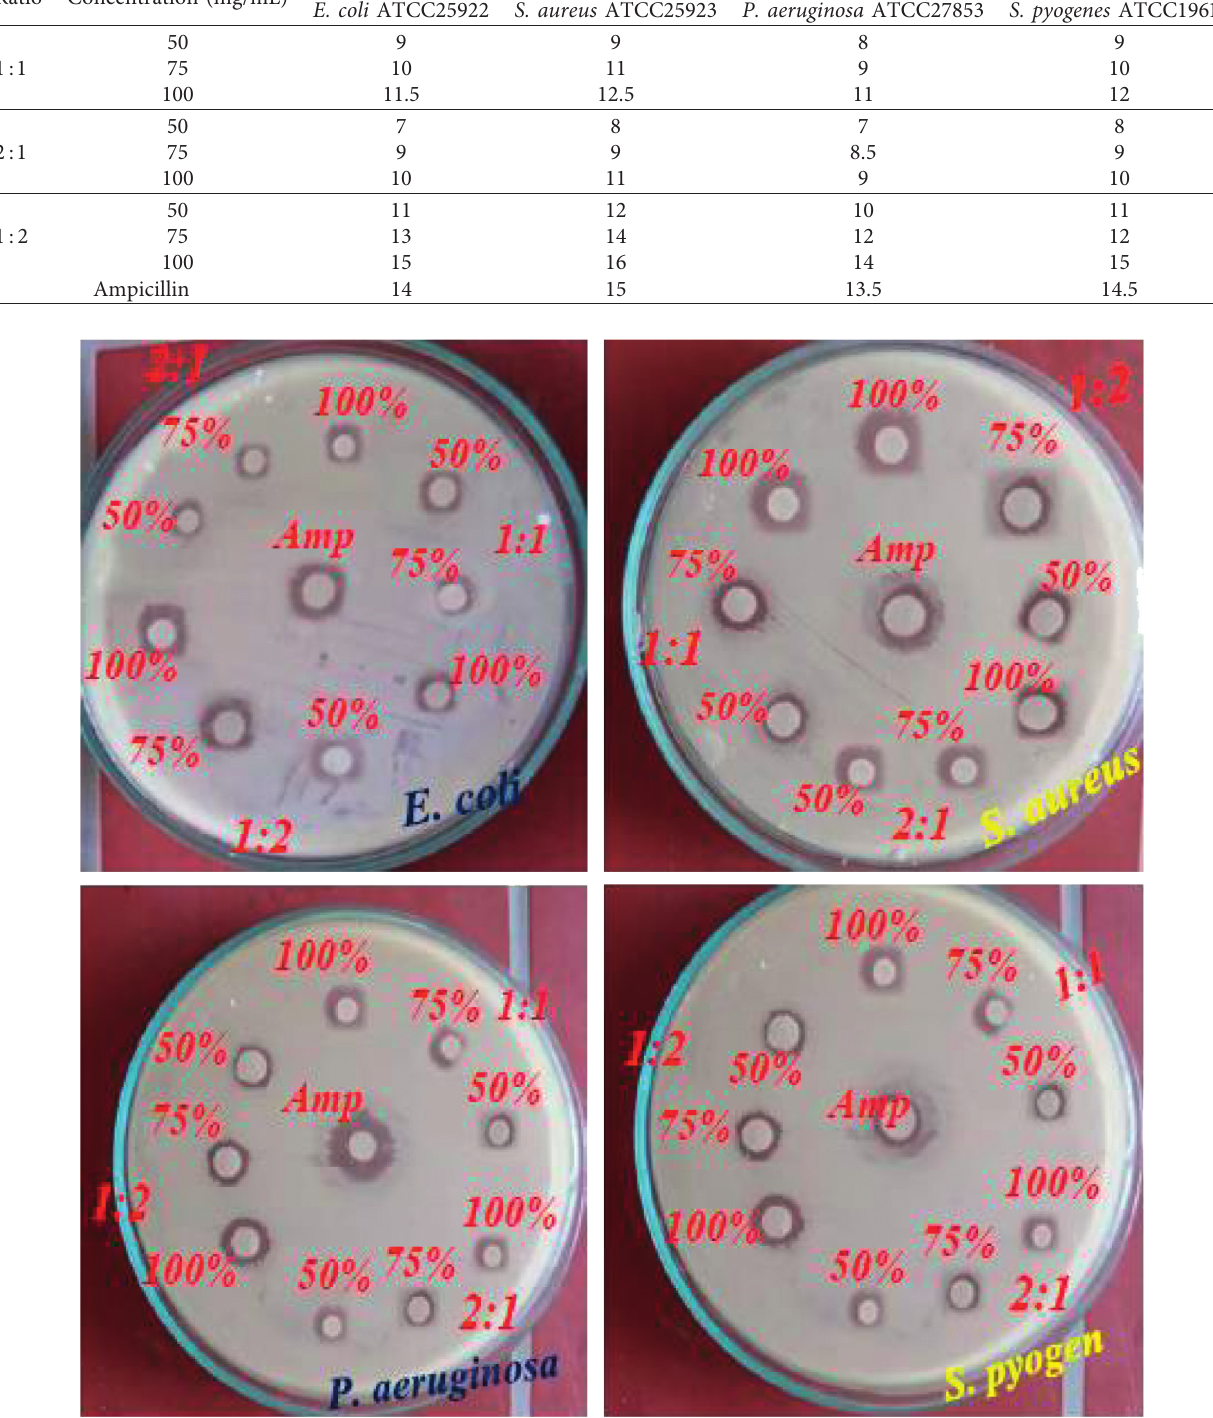
Table 2: The zone of inhibition of Co 3 O 4 nanodrugs against E. coli , S. aureus , P. aeruginosa , and S. pyogenes. Bacterial species and zone of inhibition (mm) Ratio Concentration (mg/mL)